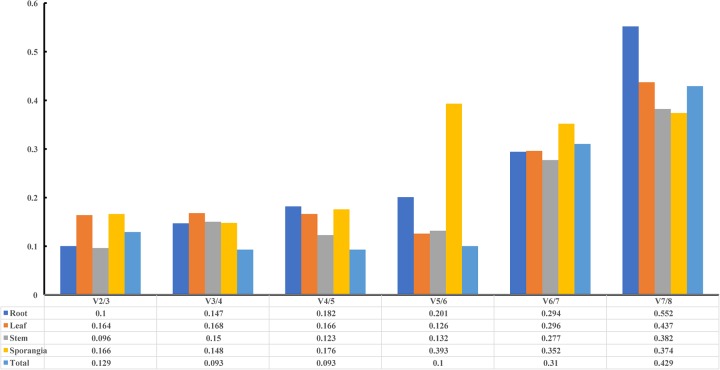
Pairwise variation (V) of candidate reference genes, as calculated by geNorm software. Vn/Vn+1 values were used to determine the optimal number of reference genes.